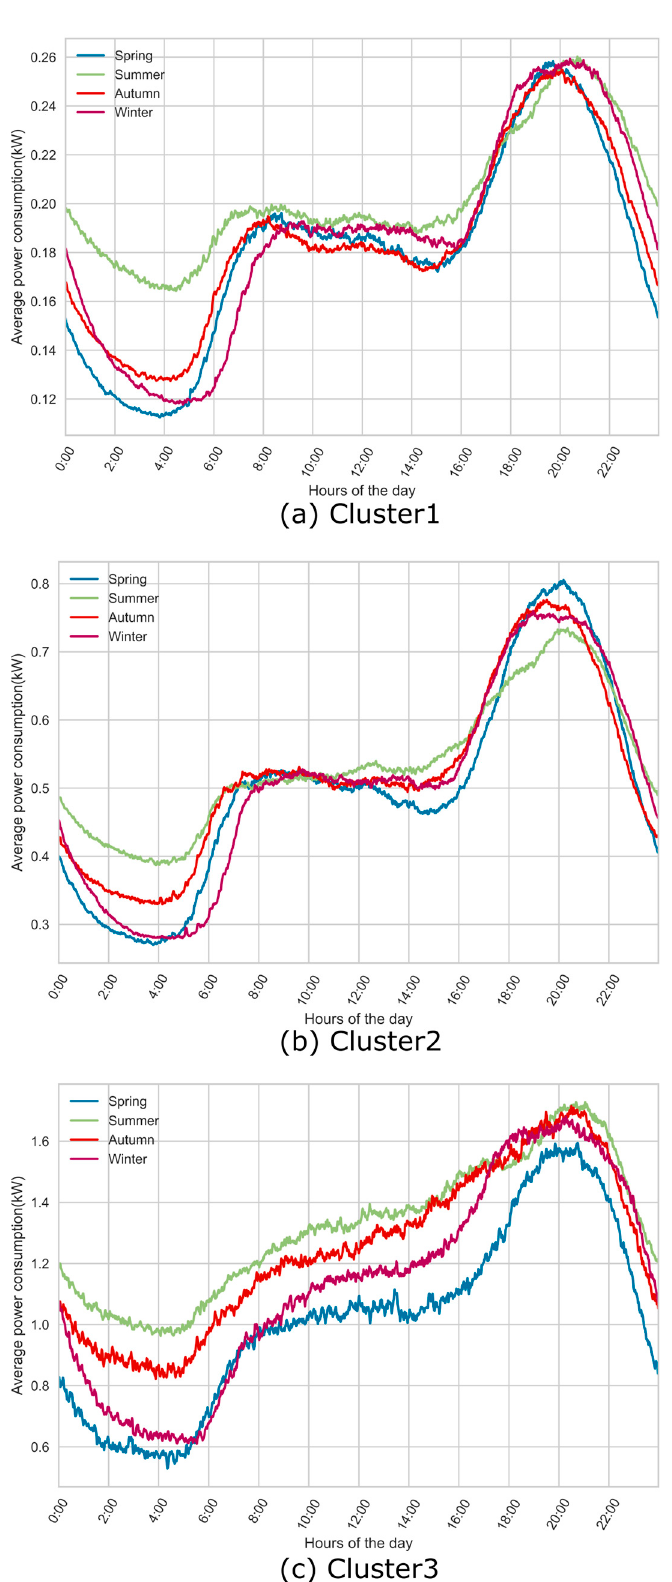
Figure 14. Seasonal average load patterns in three clusters, (a) low load consumption group, (b) middle load consumption group, and (c) high load consumption and instability group in four seasons.